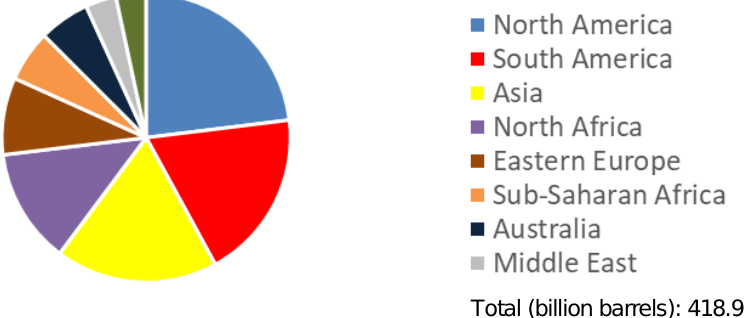
Figure 1. Technically-recoverable shale oil in eight different regions by 2015. Reproduced from [25], 2015, Energy Information Administration (EIA).